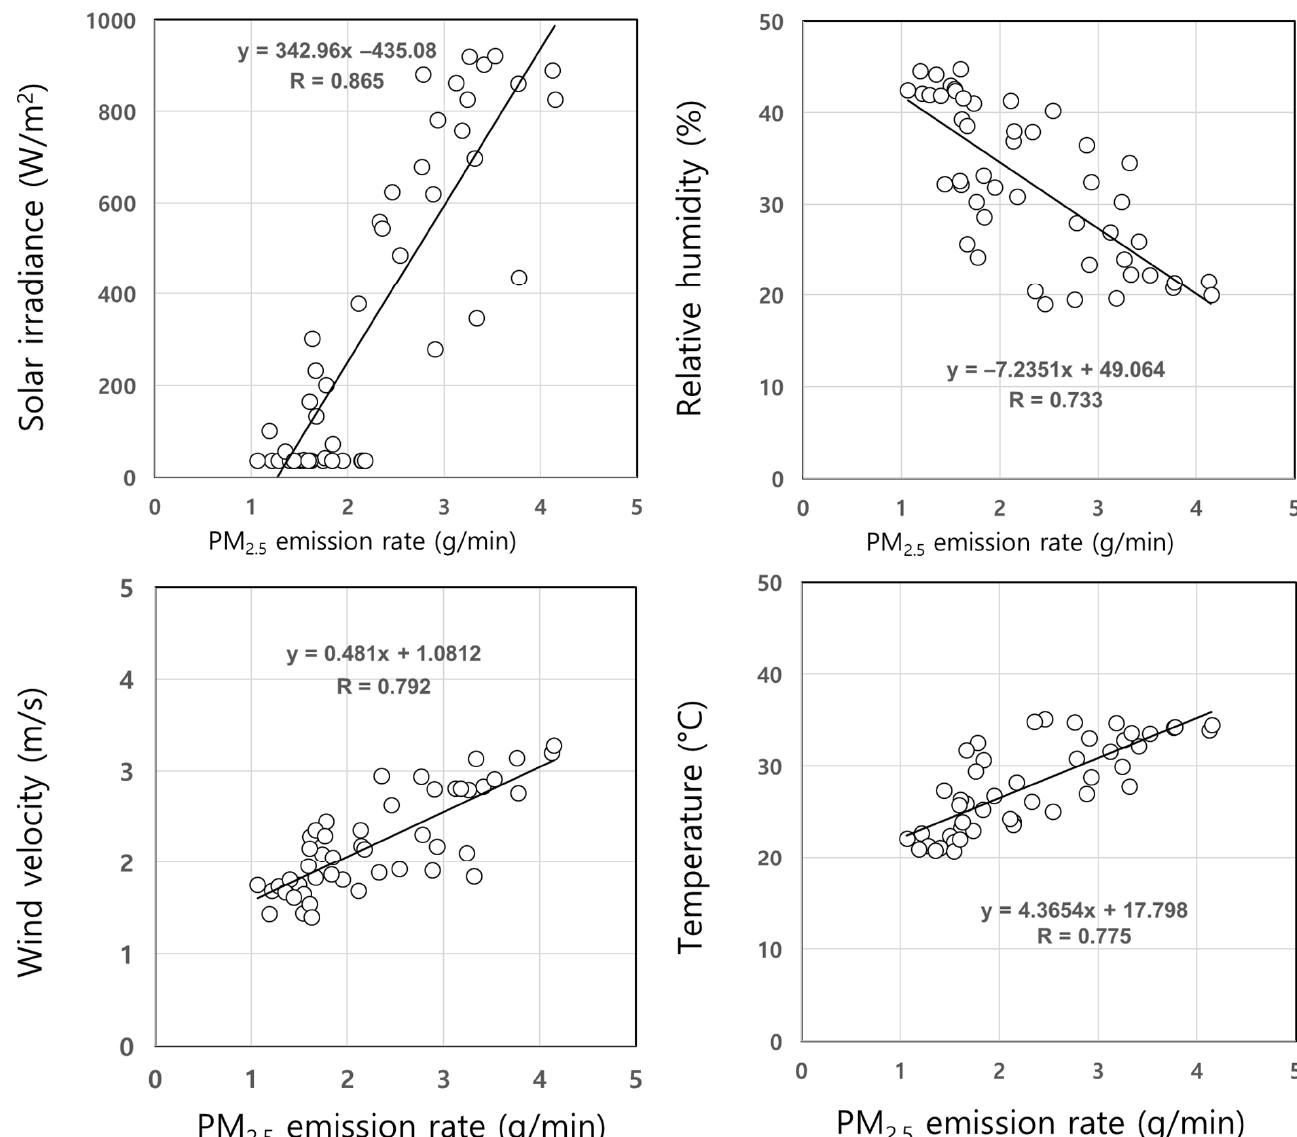
Figure 7. Correlations between PM2.5 mass emission rates and meteorological parameters in the barns ( p ‐ values for all regressions <0.001).